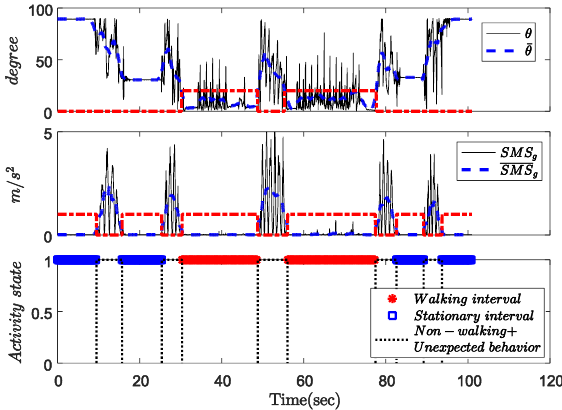
Figure 11. An example of activity classification. Upper graph: Cane angle θ . Middle graph: SMS signal. Bottom graph: Activity classification result.